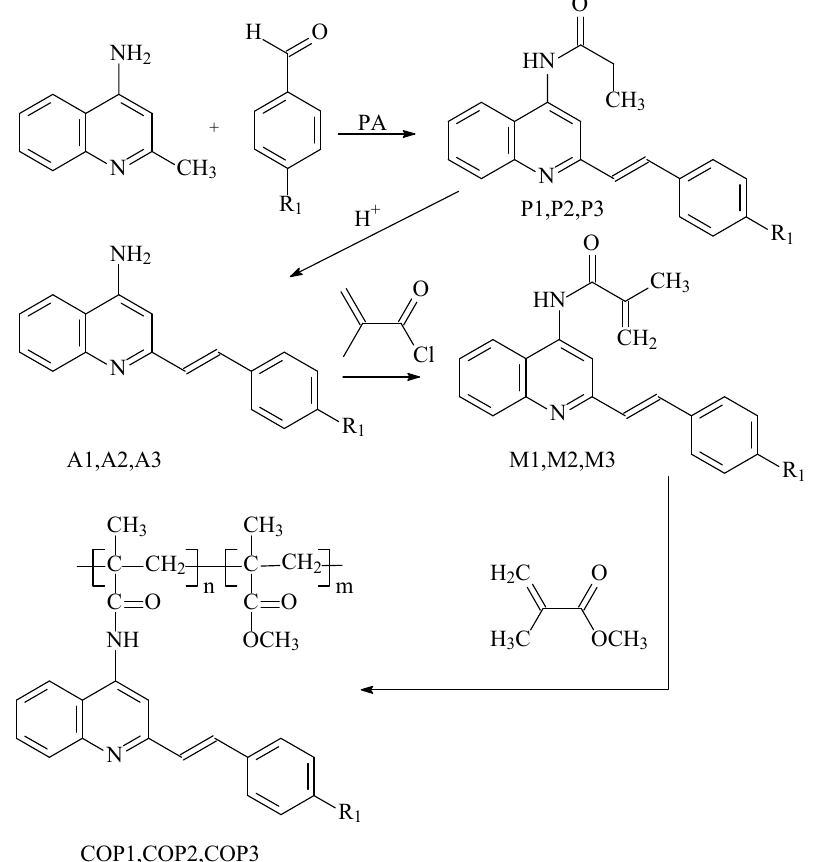
Table 1. Material properties of studied